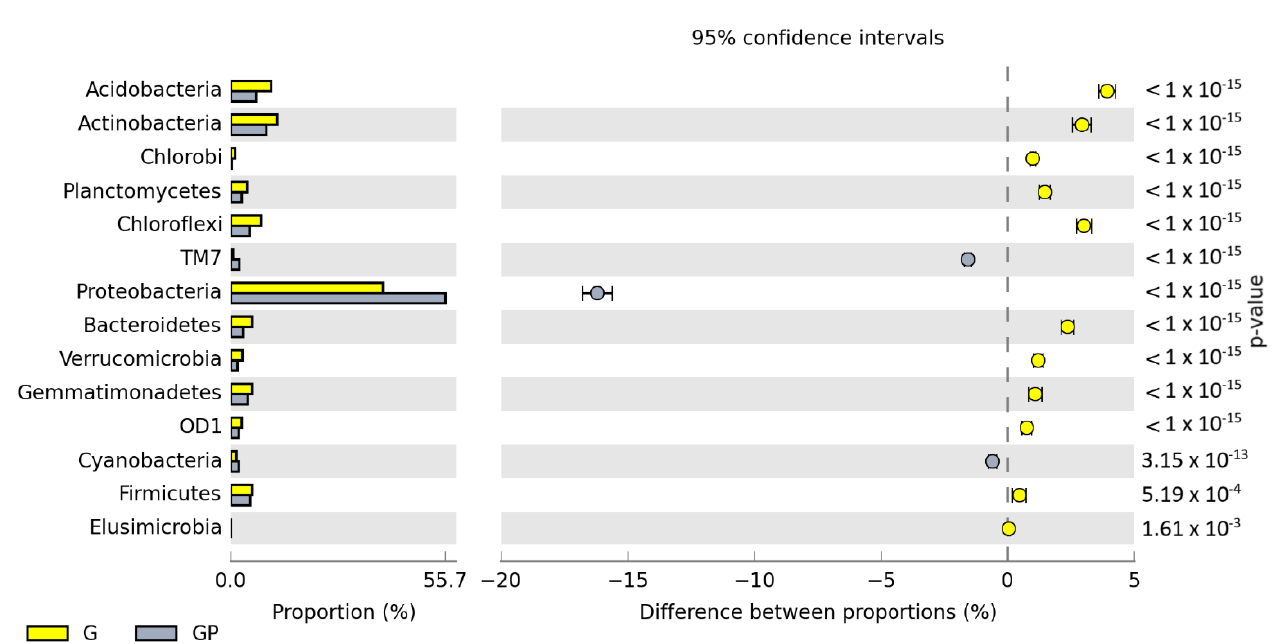
Figure 3. Comparison of the relative abundance of bacterial phyla in the soil between particular pots, with difference between the proportions at ≥ 1%. C—non-polluted and non-sown soil, G—non-polluted soil sown with cocksfoot, P—non- sown soil polluted with petrol, and GP—soil polluted with petrol and sown with cocksfoot.